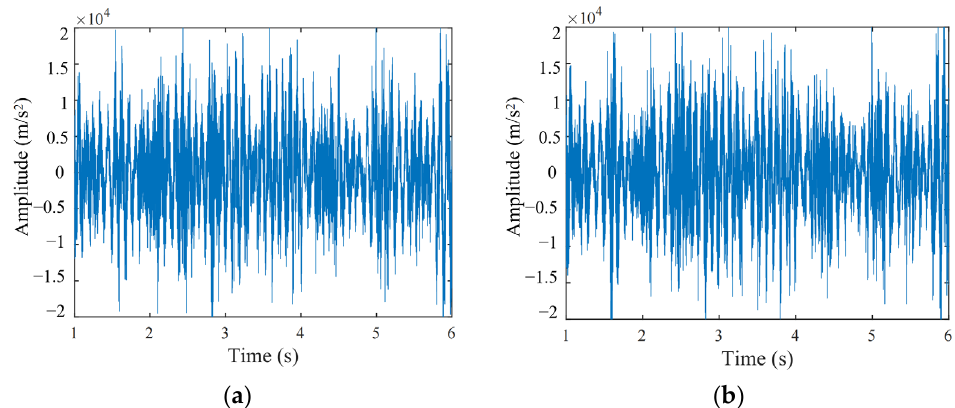
Figure 12. Vibration signal of the cutterhead support: ( a ) Before main bearing damage; ( b ) After main bearing damage.